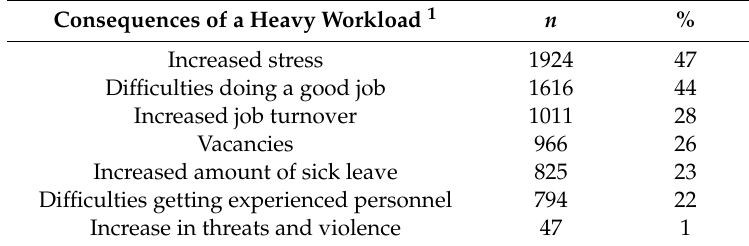
Table 3. Reported consequences of a heavy workload among occupational therapists in Sweden ( n = 3658).